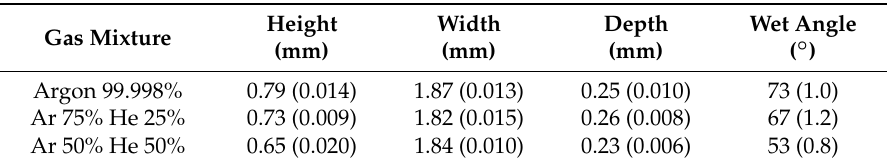
Table 10. Summary of results for experimental tests at 800 W.